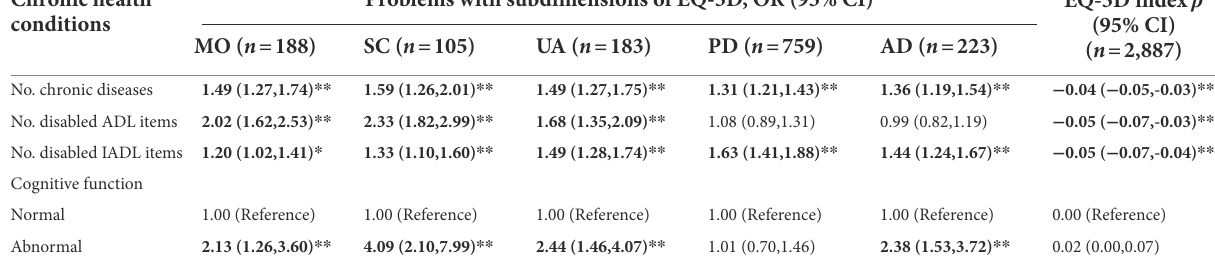
TABLE 3 The association of health-related quality of life (HRQoL) and its subdimensions with multimorbidity, functional status, and cognition. Chronic health conditions